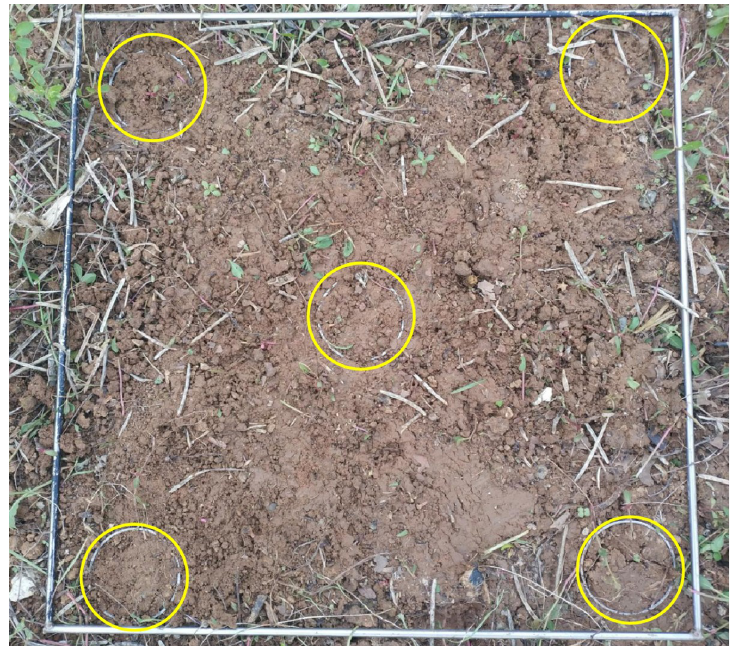
Fig 2. Five point sampling